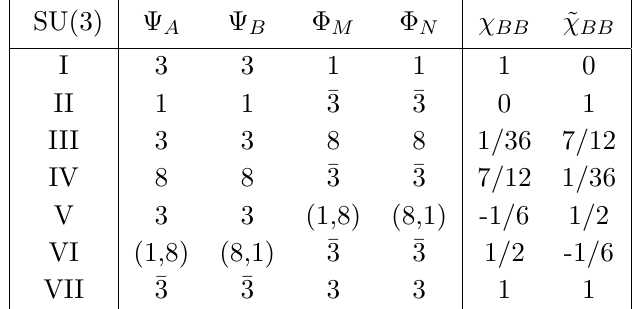
Table 3 . Table of the di(cid:11)erent SU(3) representations that can give a non-zero e(cid:11)ect via box diagrams to B s (cid:0) (cid:22) B s mixing. (cid:31) BB and ~ (cid:31) BB denote the resulting group factors.